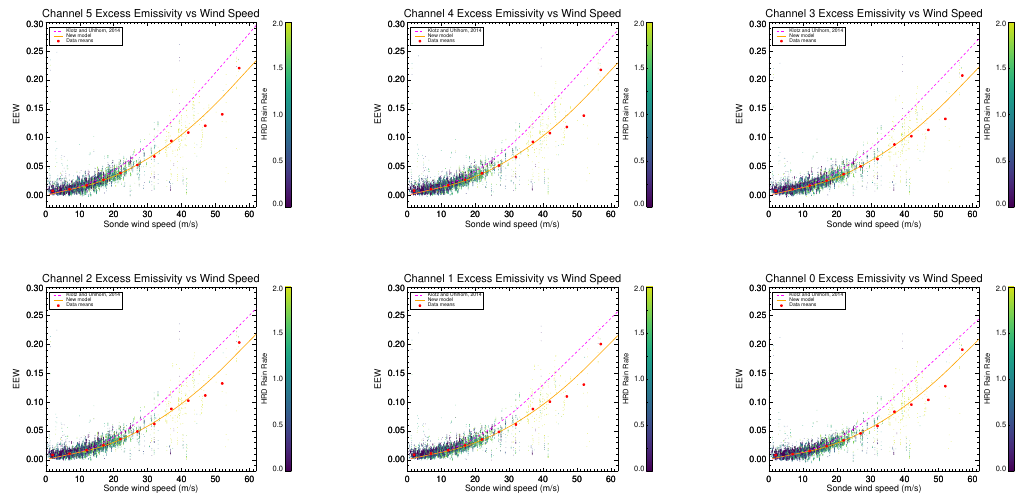
Figure 4. Corrected excess emissivity due to wind as a function of dropsonde wind speed. Also shown are the means in 5ms − 1 bins as filled circles and a fit to the means according to (5) as a solid line. The dashed line is the 2014 EEW model from [8]. The fit was only performed to means with a sufficient number of samples above 10ms − 1